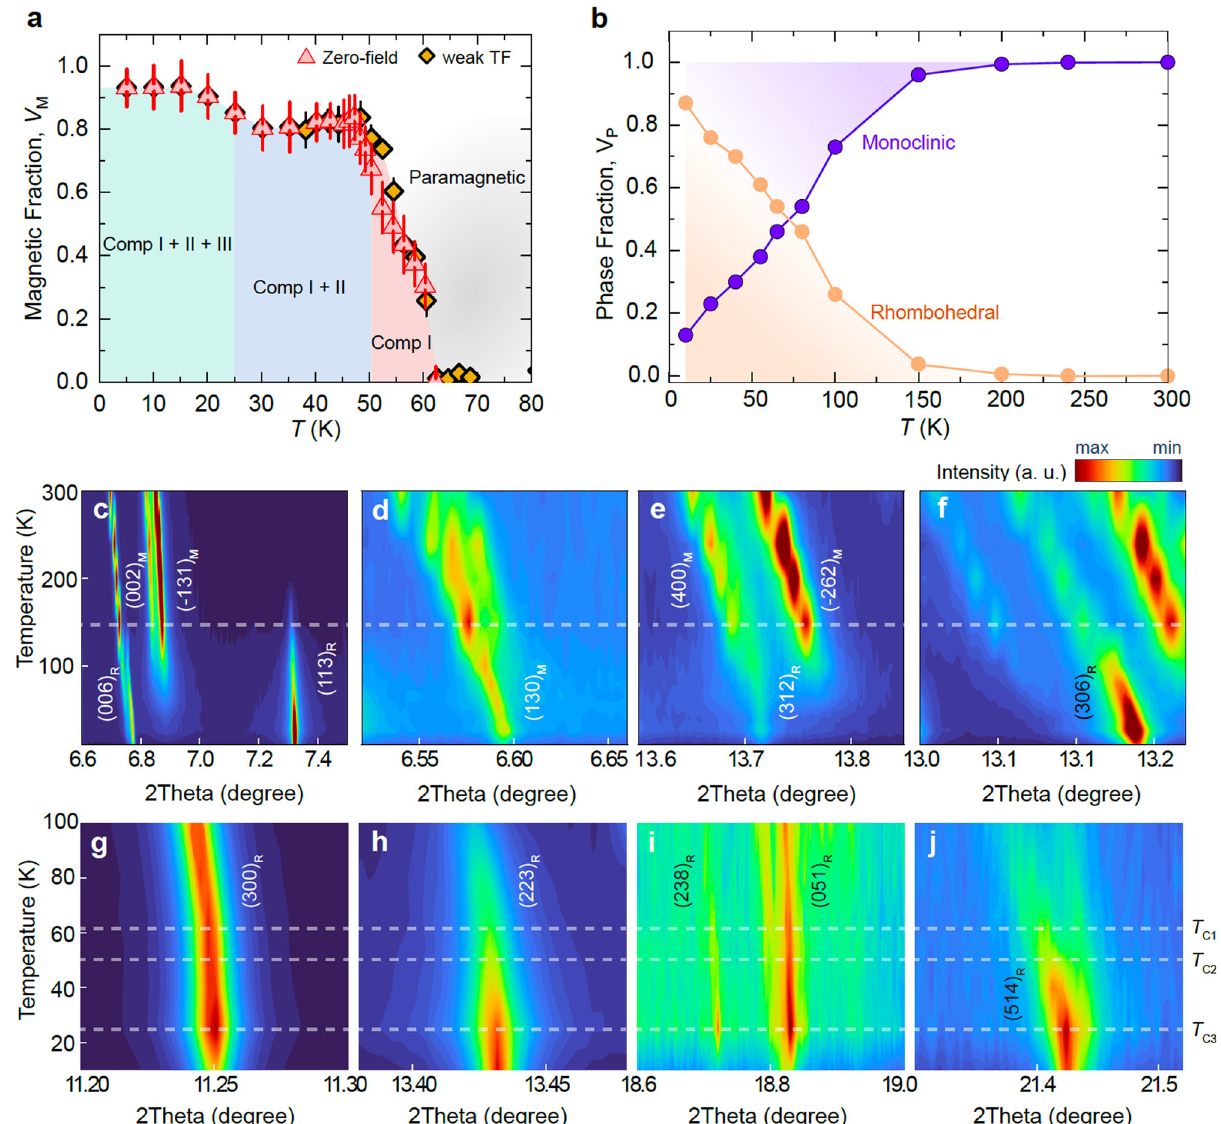
Fig. 4 Phase diagram of the various magnetic and structural phases in CrI 3 . a , The temperature dependence of the total magnetic volume fraction V M determined at accurate weak transverse fi eld (weak TF) and zero fi eld μ SR measurements. In the weak TF experiment, a small magnetic fi eld of 30 G is applied nearly perpendicular to the muon spin polarisation. The different components seen in Fig. 2 are highlighted in each region of the temperature range with the paramagnetic phase above the Curie temperature. The error bars represent the standard deviation of the fi t parameters. b The temperature dependence of the total phase fraction V P involving monoclinic (M) and rhombohedral (R) structures obtained via Synchrotron X-ray powder diffraction (SXRPD) measurements. c – f Temperature evolution below 300 K around selected monoclinic re fl ections (002) M , (-131) M , (130) M , (400) M , (-262) M . Indexation of the peaks referred to the C2/m cell. Rhombohedral re fl ections ((006) R , (113) R (312) R , (306) R ) are also included for comparison showing the coexistence of both monoclinic and rhombohedral phases throughout the entire temperature range. The dashed line at ~ 150 K highlights the increase (decrease) of rhombohedral (monoclinic) phase. g – j Temperature evolution below 100 K of the SXRPD contour plot around the rhombohedral re fl ections (300) R , (223) R , (238) R , (051) R , (514) R in CrI 3 . Indexation of the peaks referred to the R3 cell. Dashed lines mark the successive magnetic transition temperatures ( T C1 , T C2 , T C3 ) observed through μ − SR in a